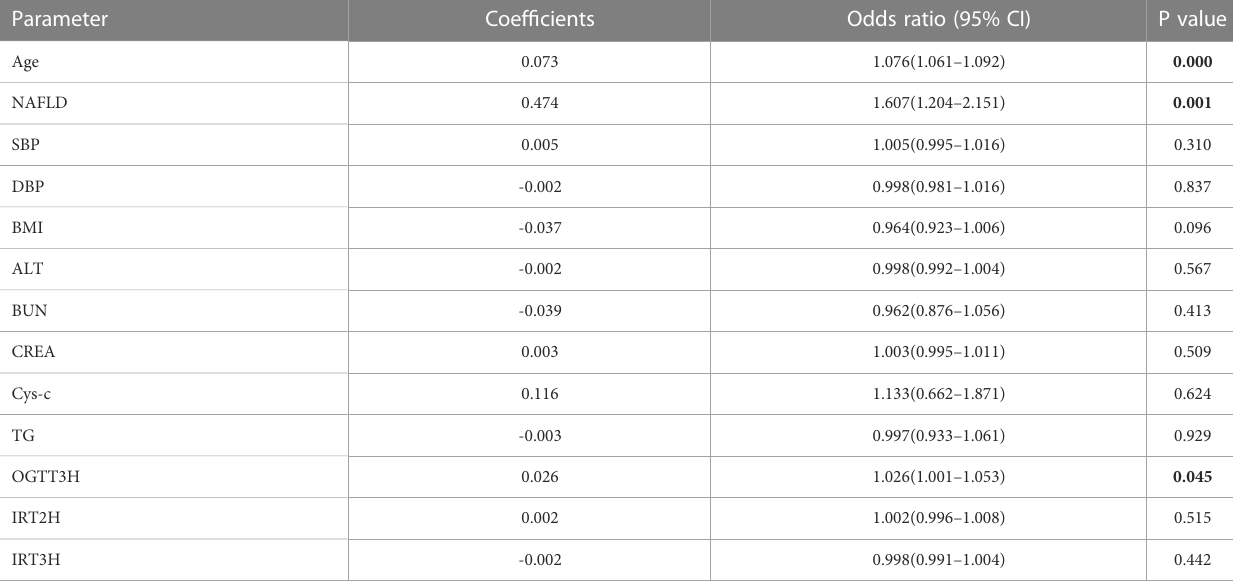
TABLE 3 Multivariate logistic regression